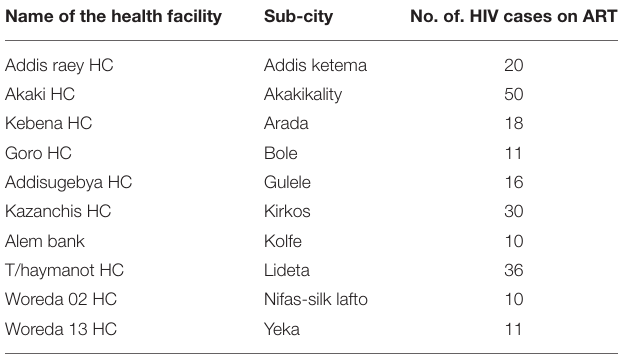
TABLE 1 | Sampling procedure. TABLE 2 | Sociodemographic characteristics of respondents, Addis Ababa, Ethiopia, May